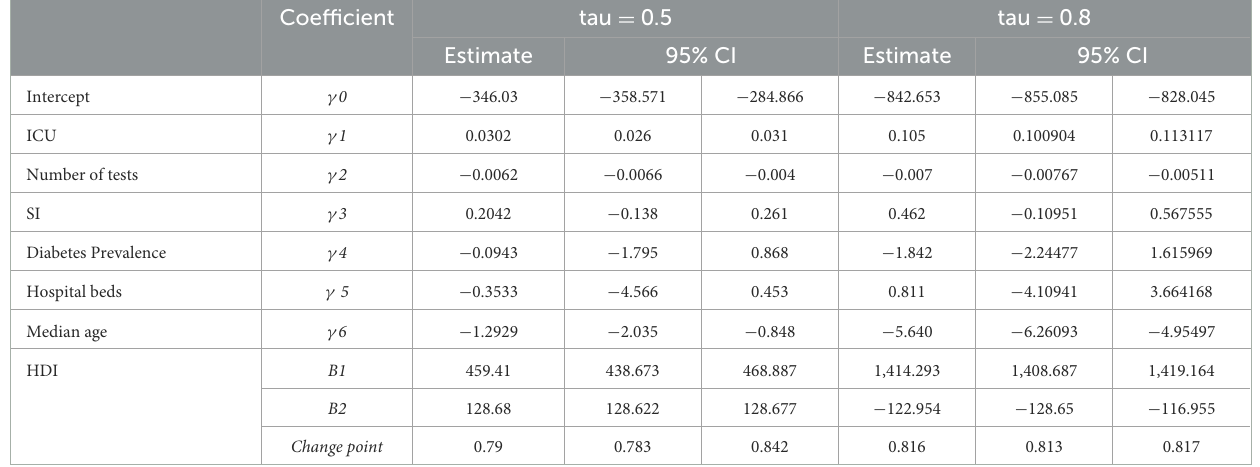
TABLE 4 Estimation of the mixed effects quantile change point regression model for COVID-19 data.